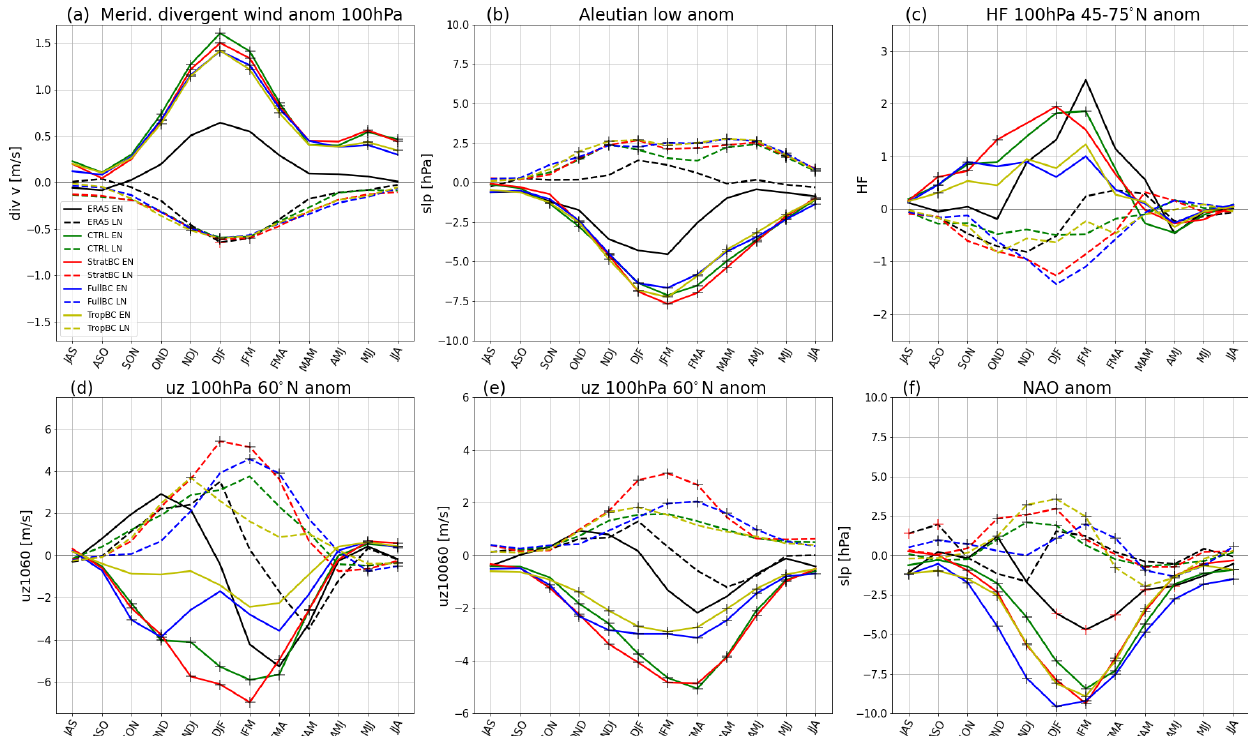
Figure 2. Progression of anomalies from the ENSO region to the stratospheric polar vortex and NAO, for the model and ERA5. The time series uses 3-month means. Black crosses indicate significance at p< 0 . 05 in the model, and red crosses are used for ERA5. For model runs solid lines show 100 years of the El Niño run minus 100 years of the neutral run, and dashed lines show 100 years of the La Niña run minus 100 years of the neutral run. ERA5 data are from 1950–2021 and show the difference between a composite of 13 El Niño (black solid lines) or 16 La Niña years (black dashed lines) and 19 neutral